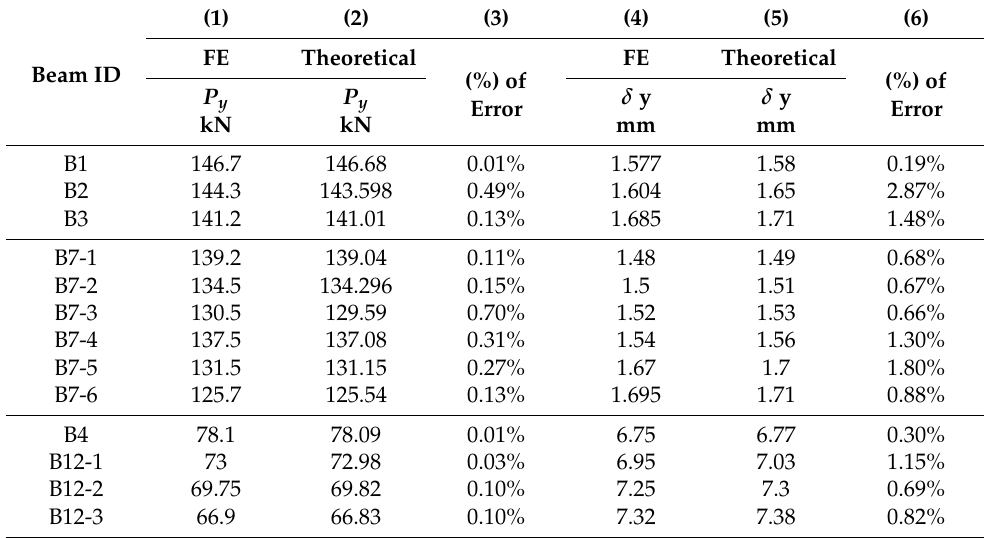
Table 7. Comparison between FE and proposed equation